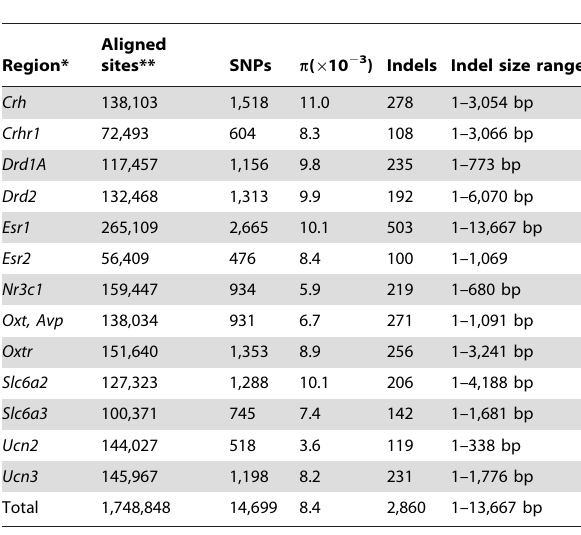
Table 3. Nucleotide diversity between alternative haplotypes.